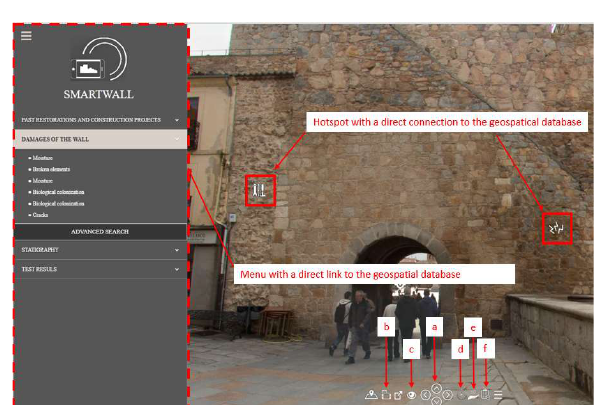
Figure 4. Disposition of the main components of the